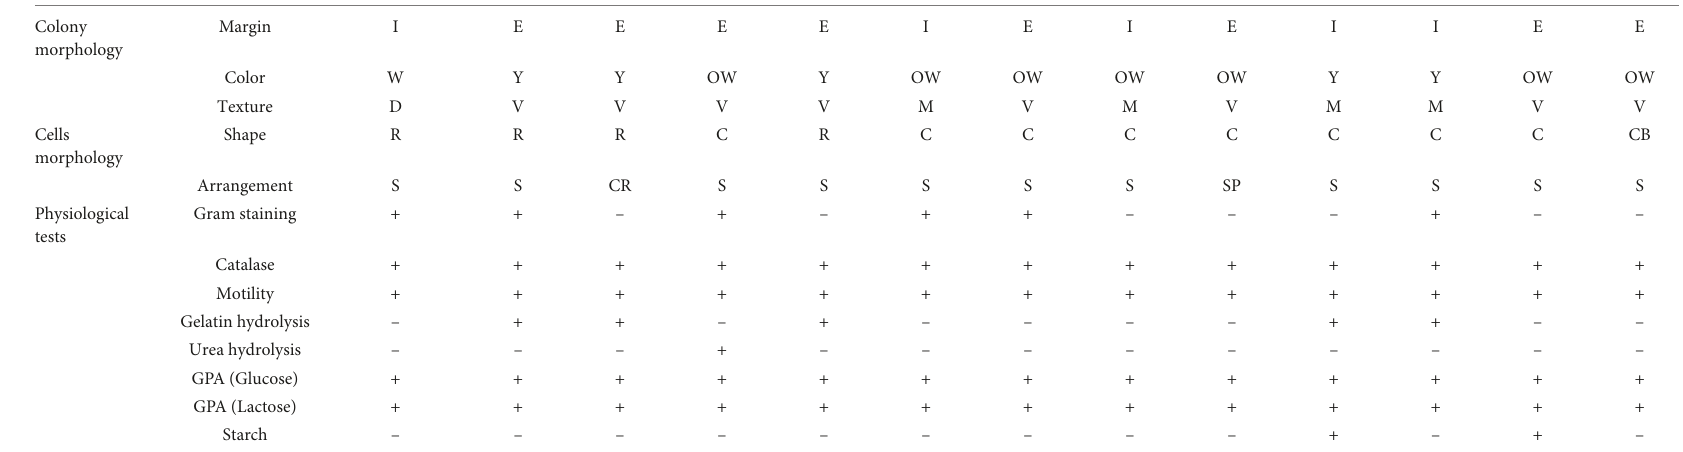
TABLE 8 Morphological and biochemical characteristics of selected strains.